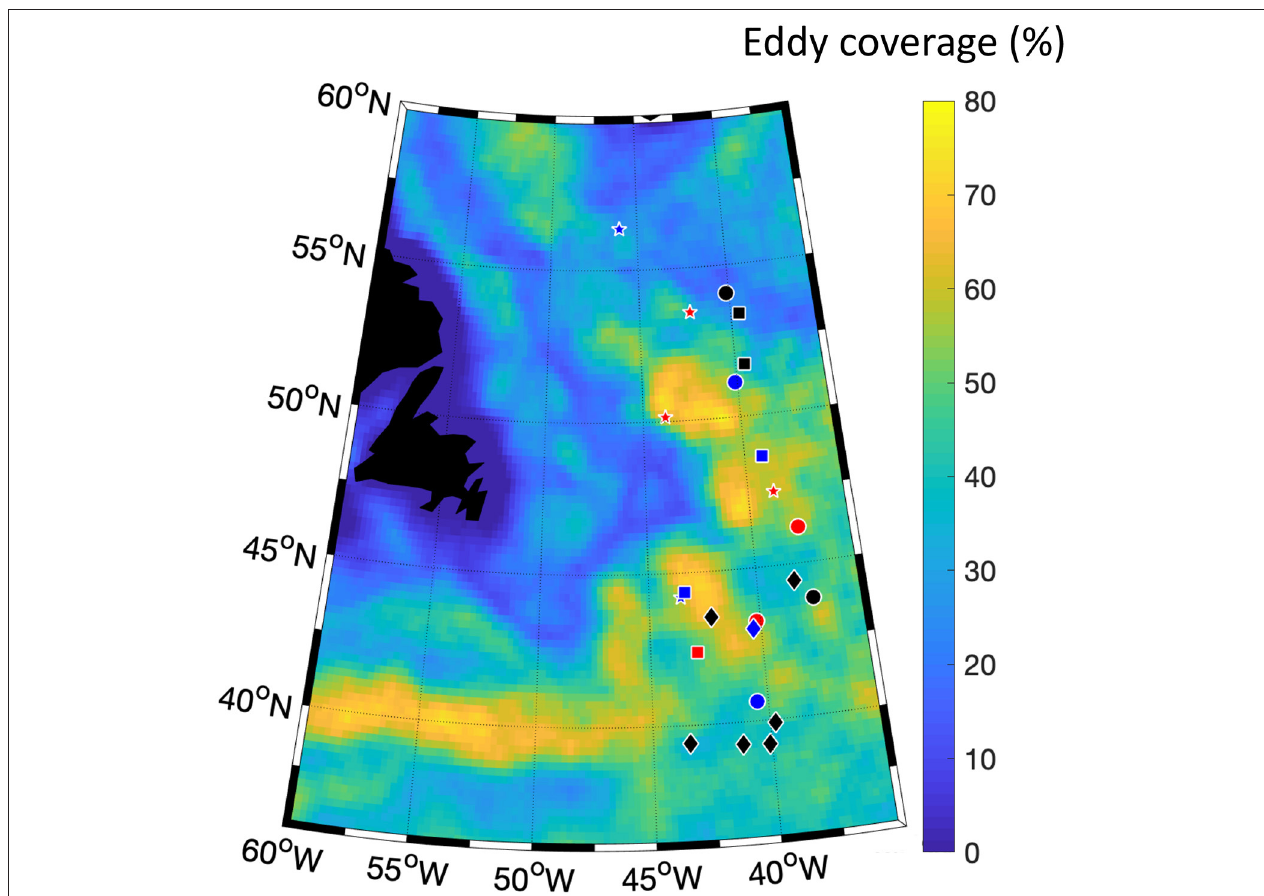
FIGURE 1 | Eddy coverage of the study area between the years 1993 and 2015. The eddy coverage was calculated as the number of days when each 1 / 4 ◦ pixel was occupied by a mesoscale eddy (defined as closed contour of Sea Level Anomaly) divided by the total number of days during the years 1993–2015. Red and blue dots indicate the locations of anticyclonic and cyclonic eddies, respectively, and black dots to the out-of-eddies sampling. Different symbols refer to different surveys: circles refer to November 2015, stars to May 2016, squares to September 2017, and diamonds to March